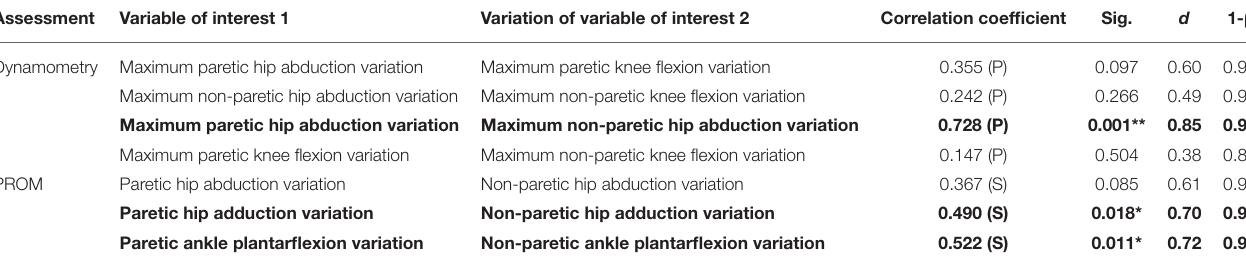
TABLE 3 | Correlations between average percentages of variation.